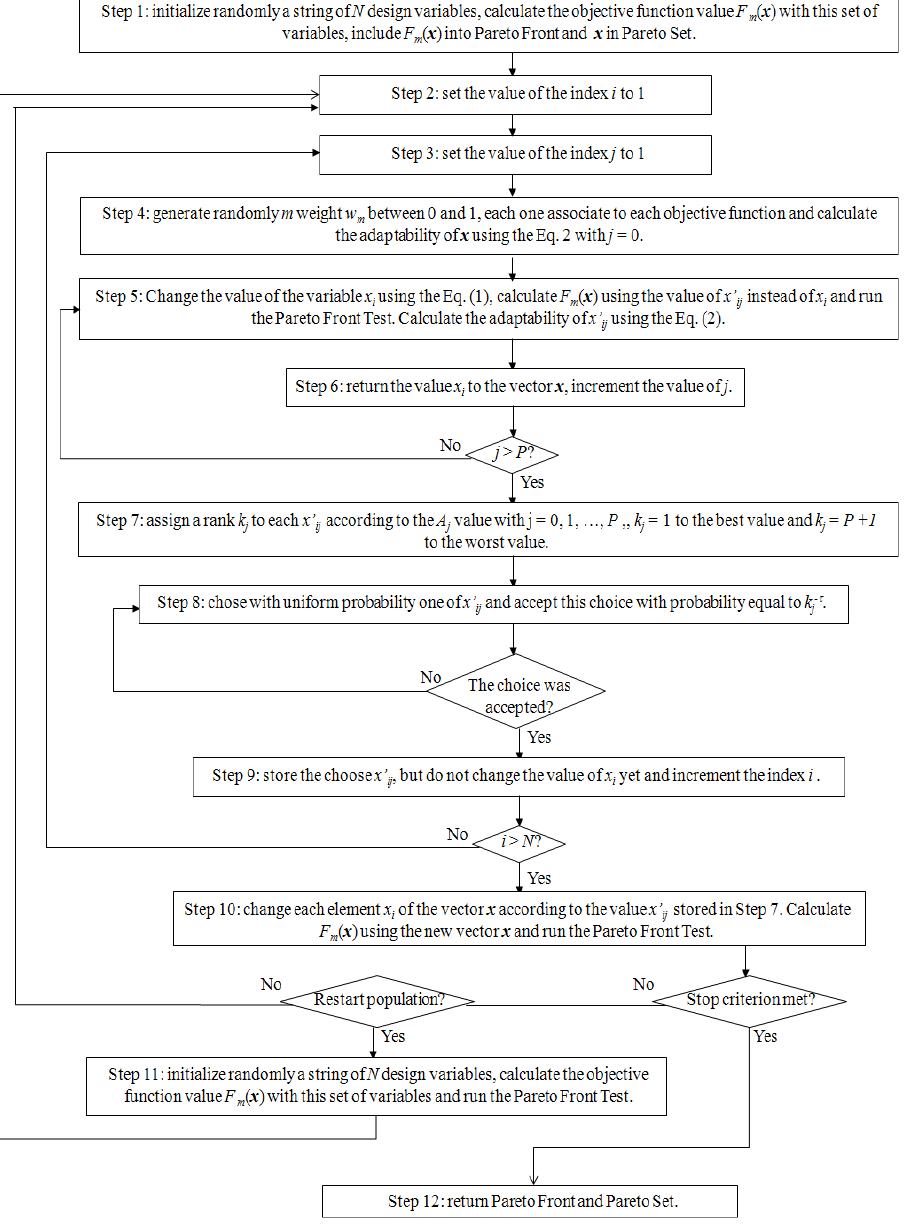
Fig. 1. M-GEO real algorithm flowchart